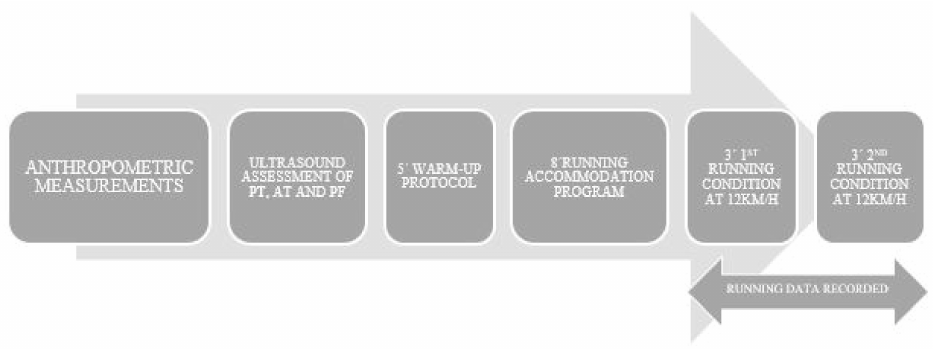
Figure 1. Temporal sequence of the protocol followed in the